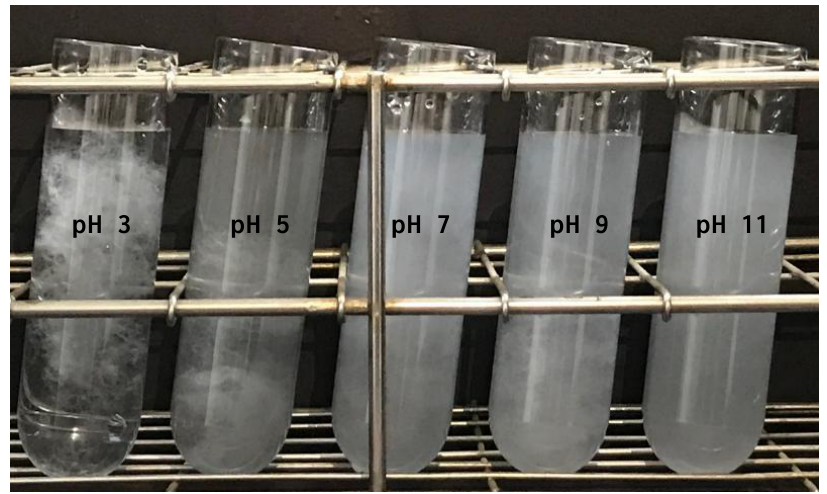
Figure 3. Images of TEMPO-oxidized PMBF suspensions after ultrasonic treatment at different pH values.